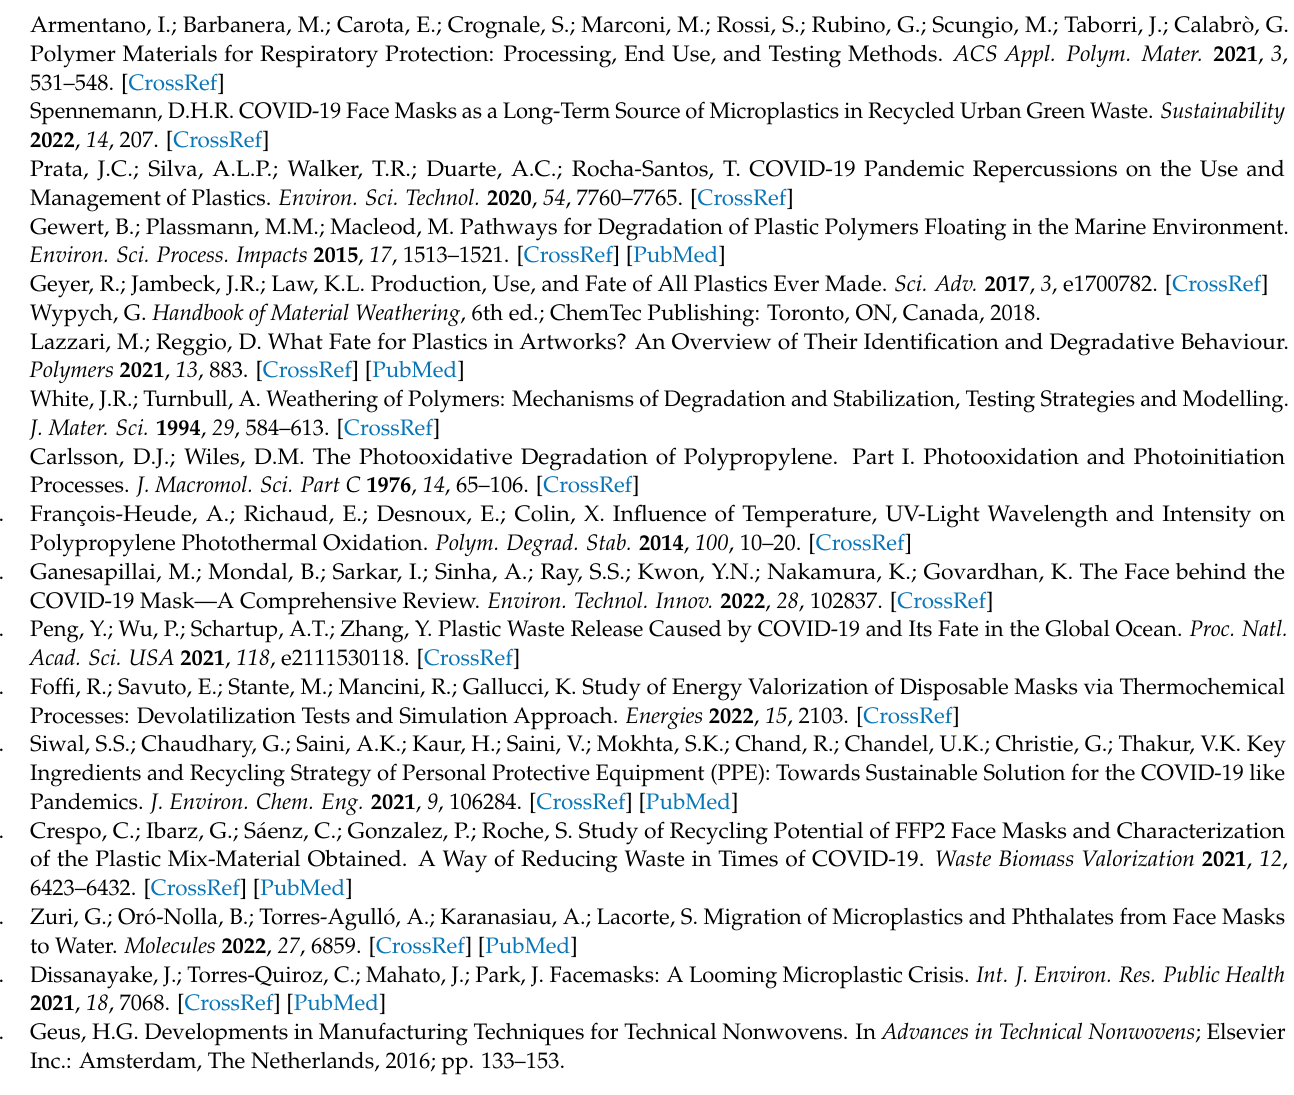
and C3; Figure S2: Optical micrograph of B1 and the dust formed from the extensive rupture of its fibers; Figure S3: DSC curves of A1 before and after 1000 h isothermal treatment; Table S1: Evolution of the CIELAB coordinates of PP layers as a function of the time of isothermal treatment at 110 ◦ C; Table S2: Evolution of the CIELAB coordinates of PP layers as a function of the time of accelerated photoaging at 24 ◦